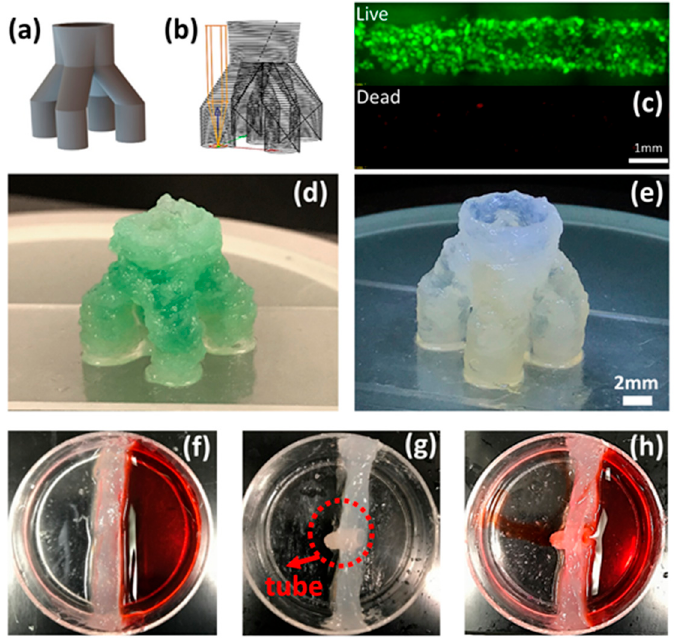
Figure 9. The design and print of a multi-tubular hydrogel structure: ( a ) the 3D CAD model of the bifurcation structure; ( b ) customized toolpath; ( c ) live/dead cell fluorescent image of single filament with cell-laden bio-ink; ( d ) the printed structure without using optimal parameters, yielding irregular surface; ( e ) the printed structure using optimal parameters, yielding a smoother surface and enhanced shape fidelity; ( f ) Nanoclay separates the petri dish to 2 parts without water leakage; ( g ) Tubular structure is buried within nanoclay; ( h ) Water stained in red flow automatically to the left side.